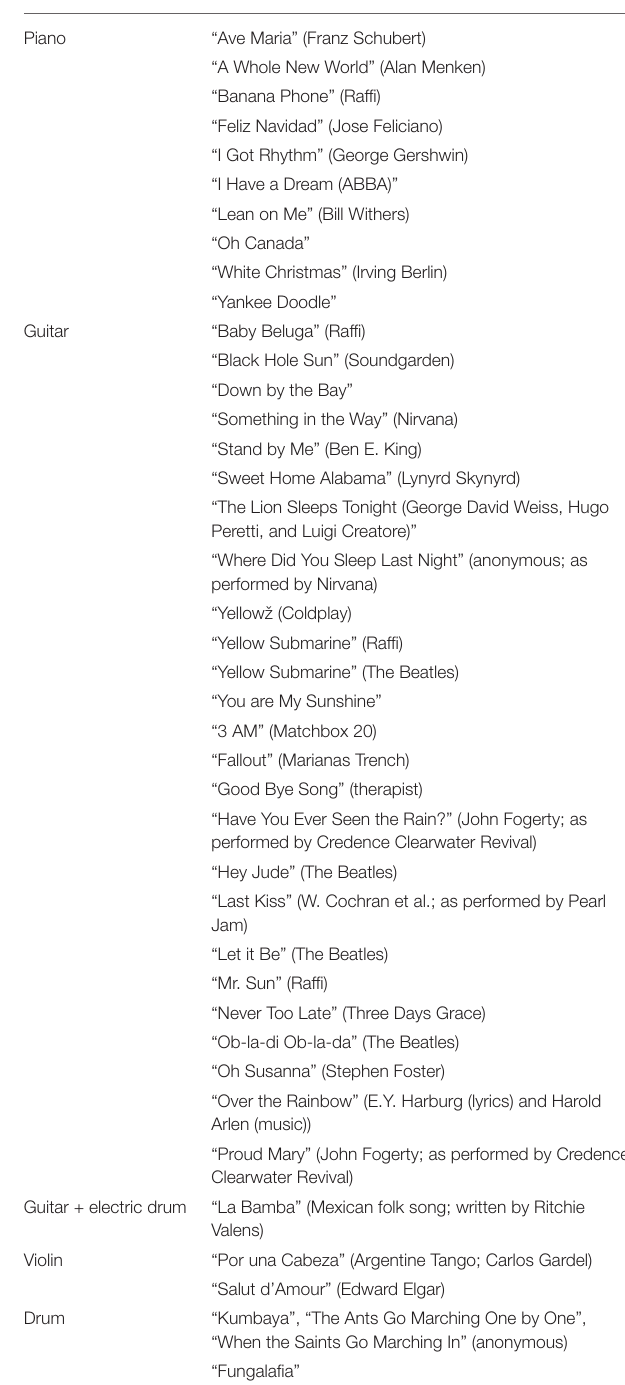
TABLE 2 | Intervention theory. Rationale for music selection Preferred music according to parental recommendation and documentation of music by previous music therapists who had worked with the child (if applicable); further selections of songs similar in genre, artist and style to those familiar to